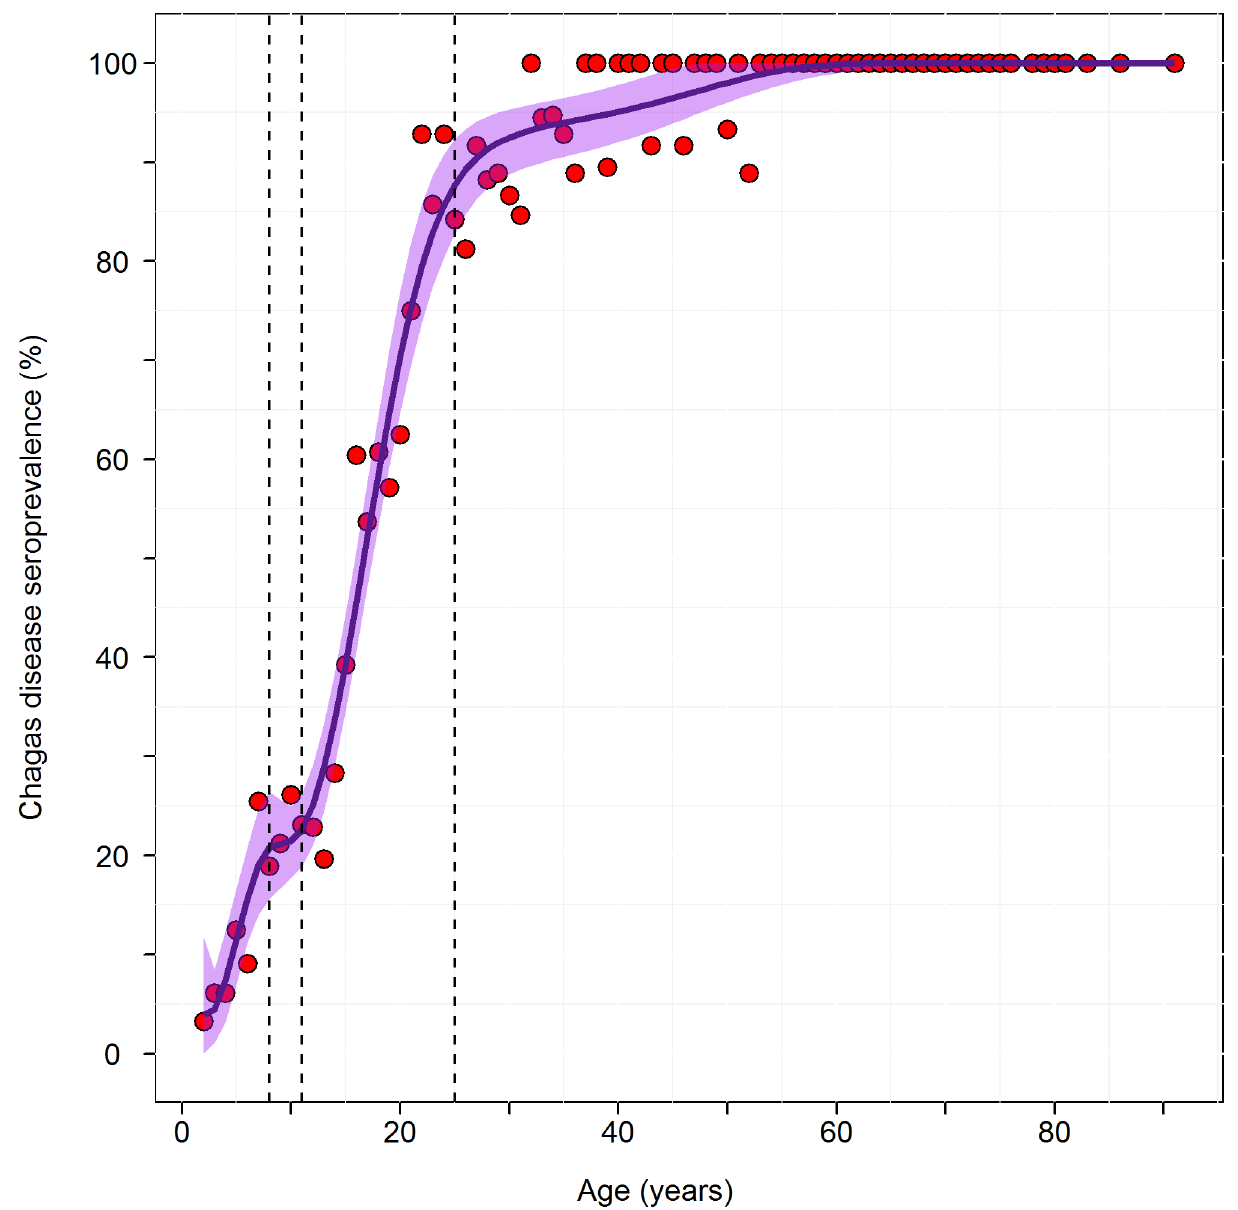
Figure 2. Estimated seroprevalence based on the spline model. Gray shading around the seroprevalence curve represents 95% confidence intervals of model to data points. Vertical dashed lines indicate where knots corresponding to the years of blanket spray campaigns are included in the model. doi:10.1371/journal.pntd.0002358.g002 testing of vectors from our study site (P. Marcet, unpublished data, 2011).